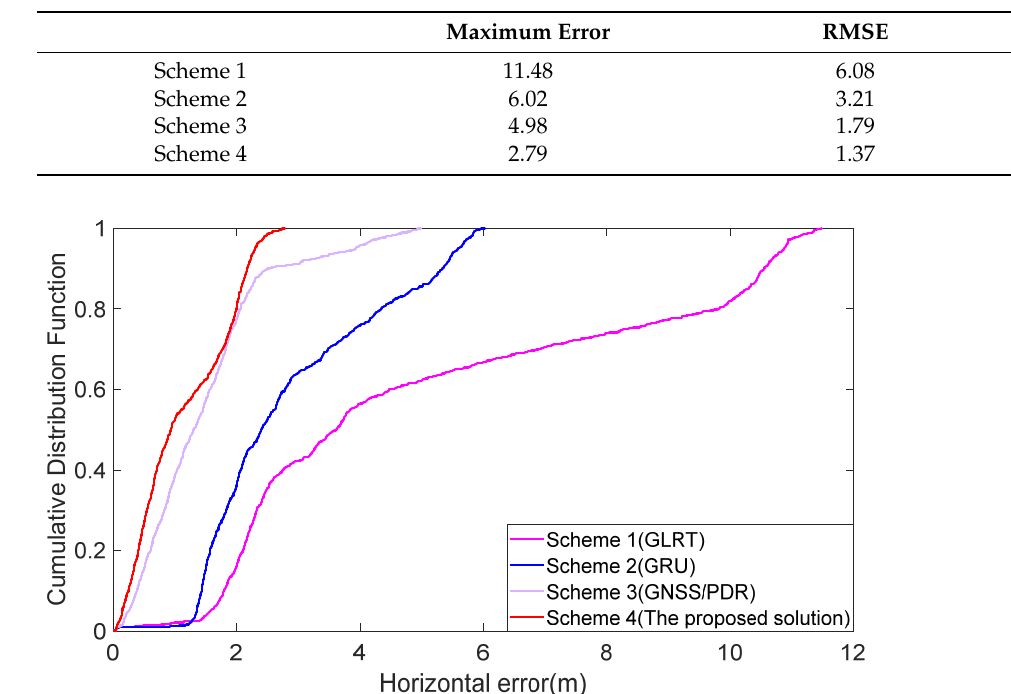
Figure 13. Horizontal error statistics of different schemes. Table 4. Horizontal position error (m) obtained by different schemes.